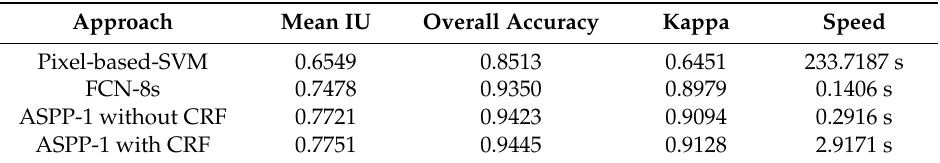
Table 8. Classification results of FCN-8s and our approach. The metrics of speed is measured in seconds by the inference time of a single image.